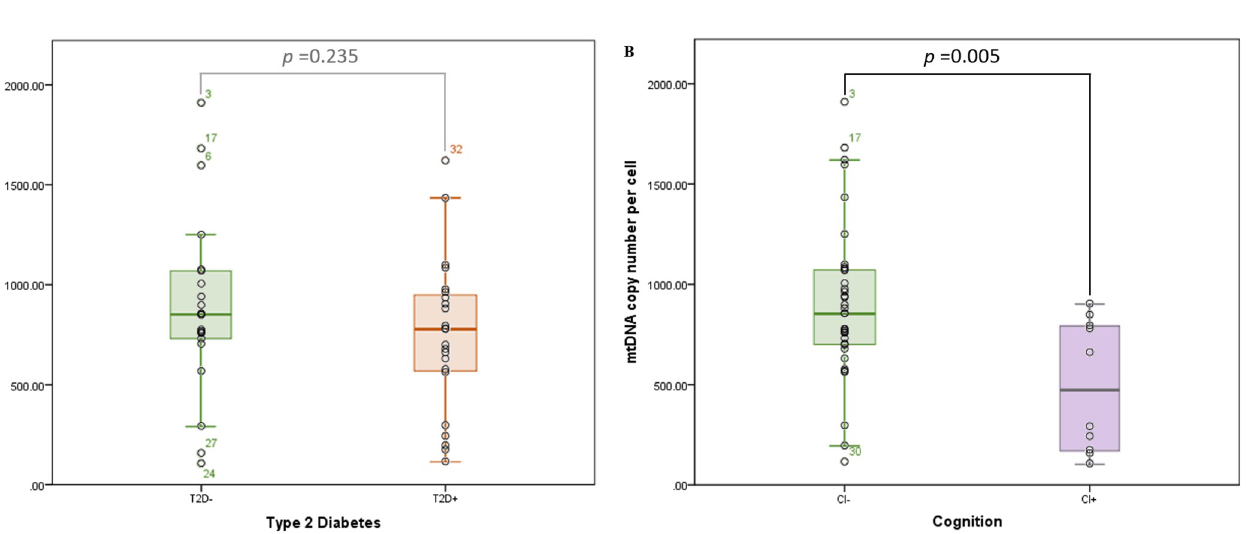
Fig 4. Average mitochondrial DNA copy number per cell stratified by diabetes and cognitive status. Copy number of mitochondrial genomes appears to be lower in individuals with (A) diabetes (t-test p-value = 0.235, insignificant) or, (B) cognitive impairment (t-test p-value = 0.005). A larger effect was observed for cognitively impaired